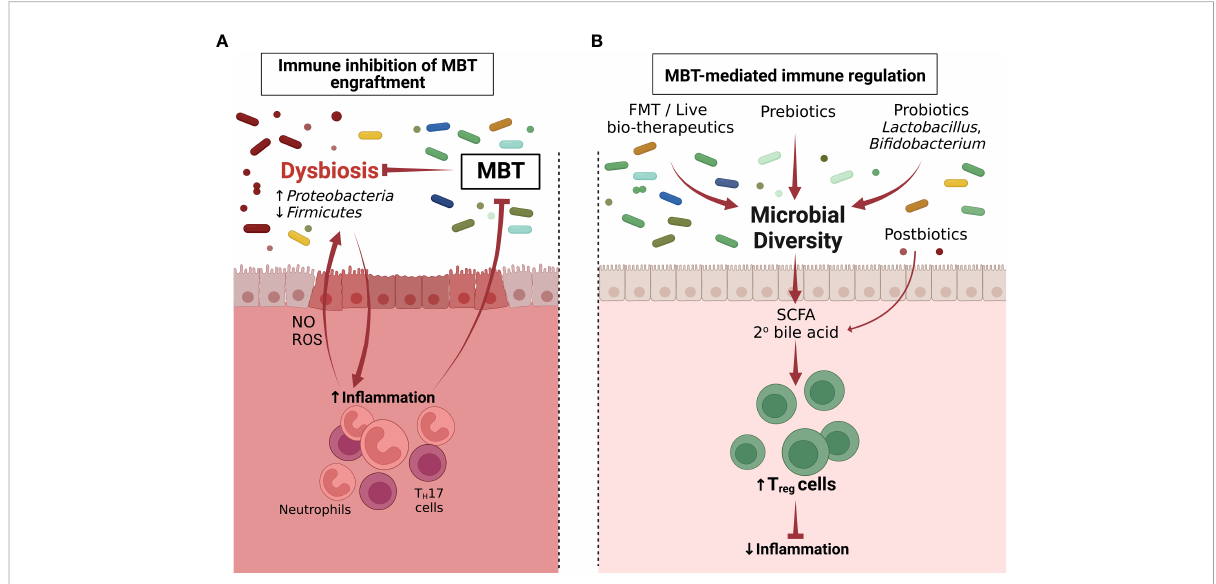
FIGURE 1 Microbiome-immune cell interactions determine the failure and success of microbiome-based therapies (MBTs). (A) In fl ammation associated with dysbiosis renders the intestinal environment refractory to MBT engraftment (Section 4). (B) MBT can promote therapeutic effects through immune regulation following administration (Section 5). Following successful MBT engraftment, the overall microbiome diversity increases. Postbiotics or metabolites produced by incoming bacteria including SCFAs and 2° bile acids can induce CD4 + T reg cells, which reduce in fl ammation and restore the immune homeostasis of the